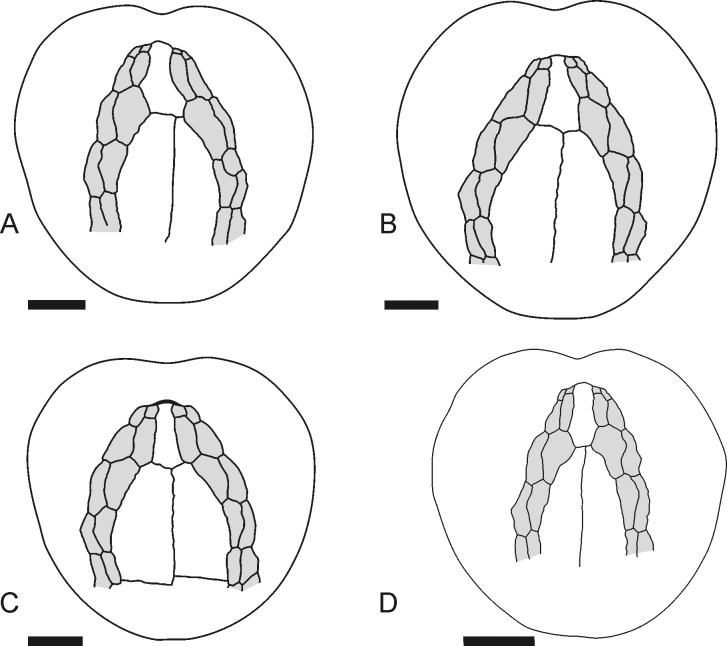
Sketches illustrating the variation in the periplastronal ambulacral plates.(A-B) Conspicuous asymmetric development. (C-D) Symmetric development, with longer ambulacral plates (C) and shorter plates (D) next to the labrum (A: MB.E.8196, Liencres area, Spain; B: GSUB E3847, Erwitte area, Germany; C: GSUB E3867, Erwitte area, Germany; D: MB.E.8257, Liencres area, Spain). Scale bars equal 1 cm.